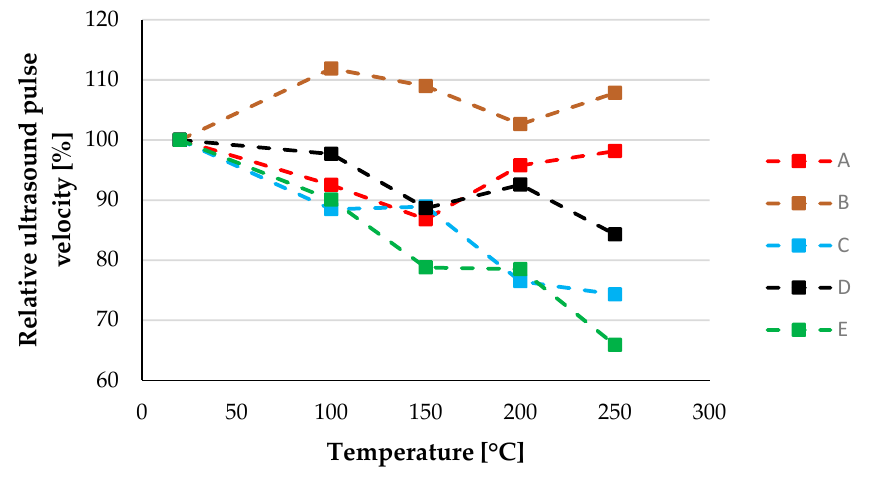
Figure 4. Ultrasound pulse velocity (%) vs. exposure temperature.